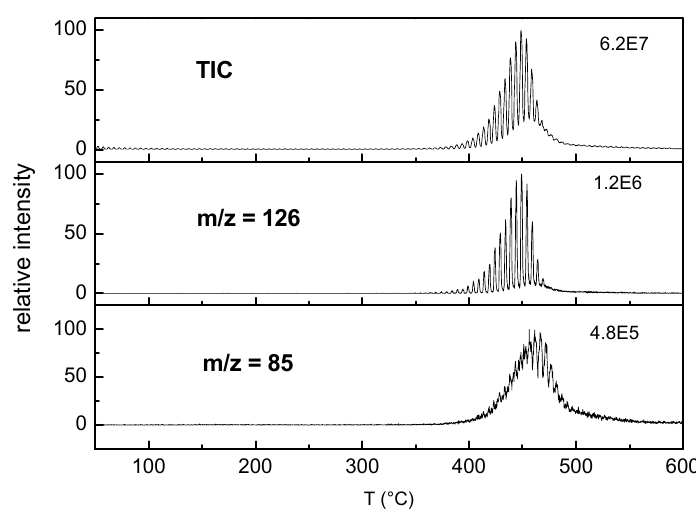
Figure 3. TGA-GC-MS chromatograms. Total ion current (TIC) chromatogram and the Selected Ion Monitoring (SIM) chromatograms at 126 and 85 m / z are reported.